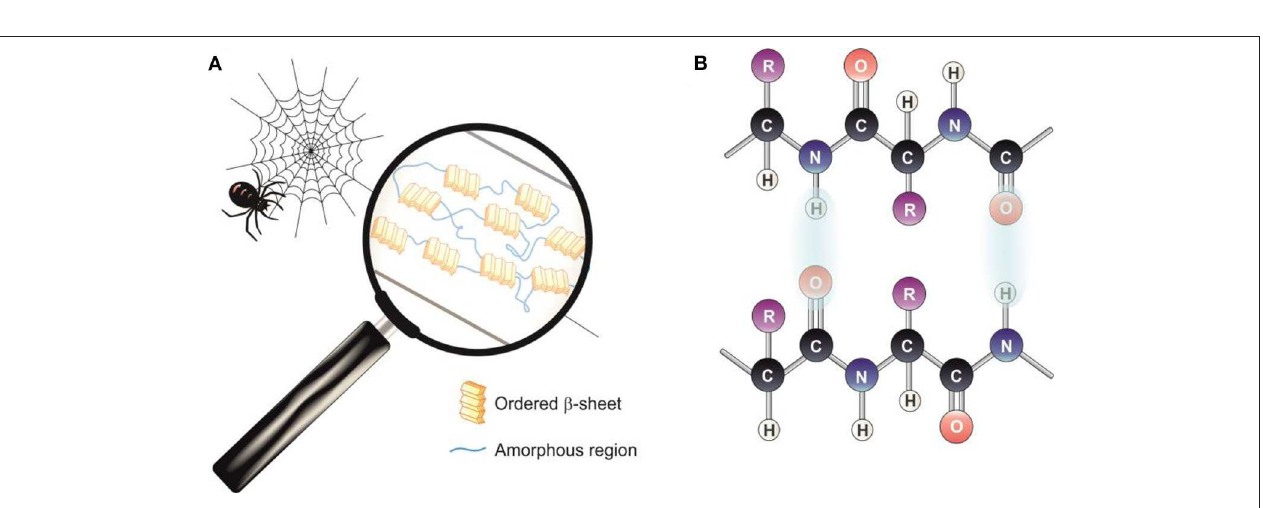
such as the substituents in the main chain and the components in the amorphous region, are located at higher BE (290.51